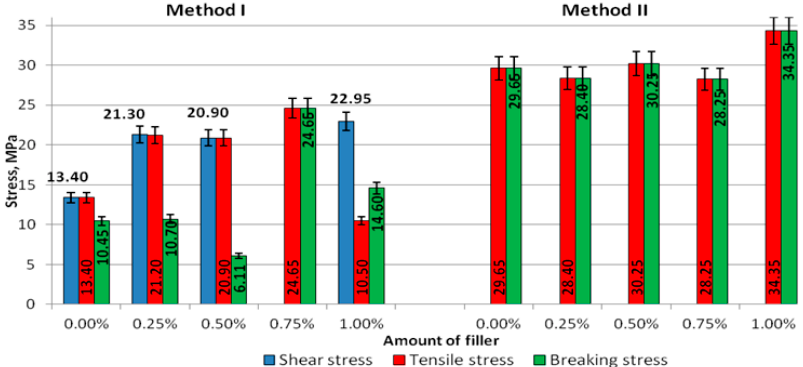
Figure 6. Comparison of the stresses in the adhesives prepared with Methods I and II.